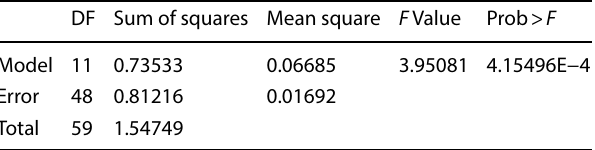
DF Sum of squares Mean square F Value